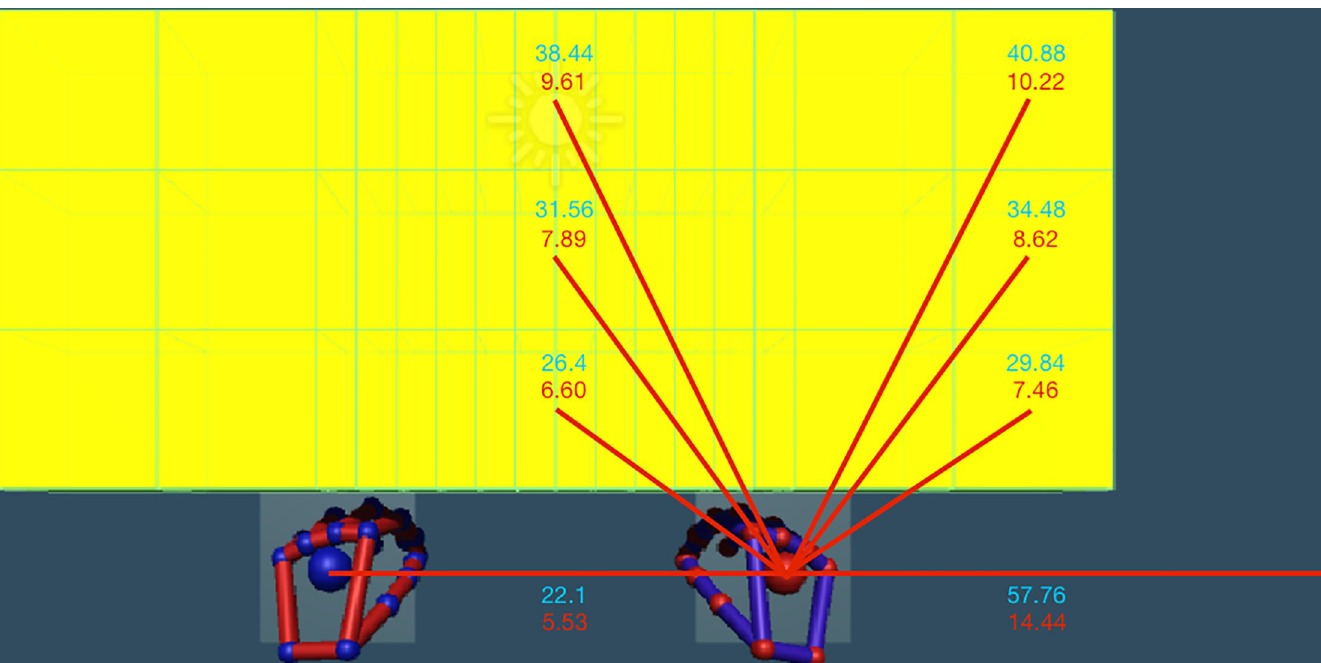
Fig 1. Hand and stimulus configuration. This figure shows all possible stimuli positions on the screen, as well as the initial position of the hands. Each yellow cube is delineated by thin green lines (not present in task) and was presented independently of the others. The red values are virtual 3D space distances on the computer screen in cm, including simulated depth in virtual space. The black values are the distances for corresponding direct movements between respective locations in real 3D space in cm.